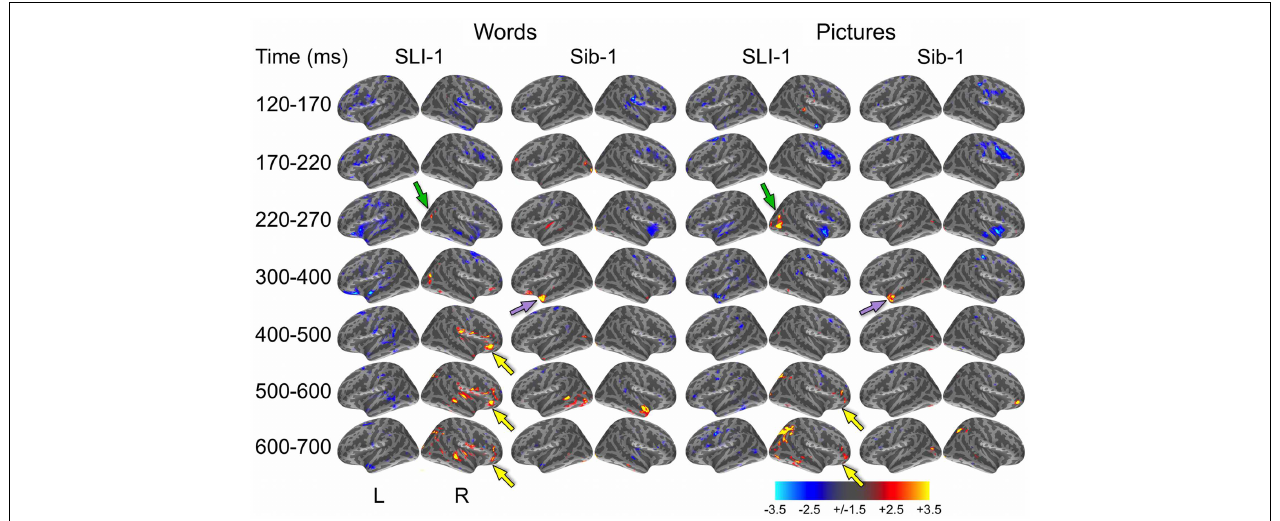
(green arrows), as well as later over-recruitment of right frontal opercular regions during semantic latencies (yellow arrows). Compared to controls, Sib-1 showed early under-engagement of right anterior regions for words and pictures, consistent over-engagement of left temporal pole 300–400ms (violet arrows), and over-recruitment of several left and right areas at the latest time windows. Color scale represents z -statistics (standard deviation